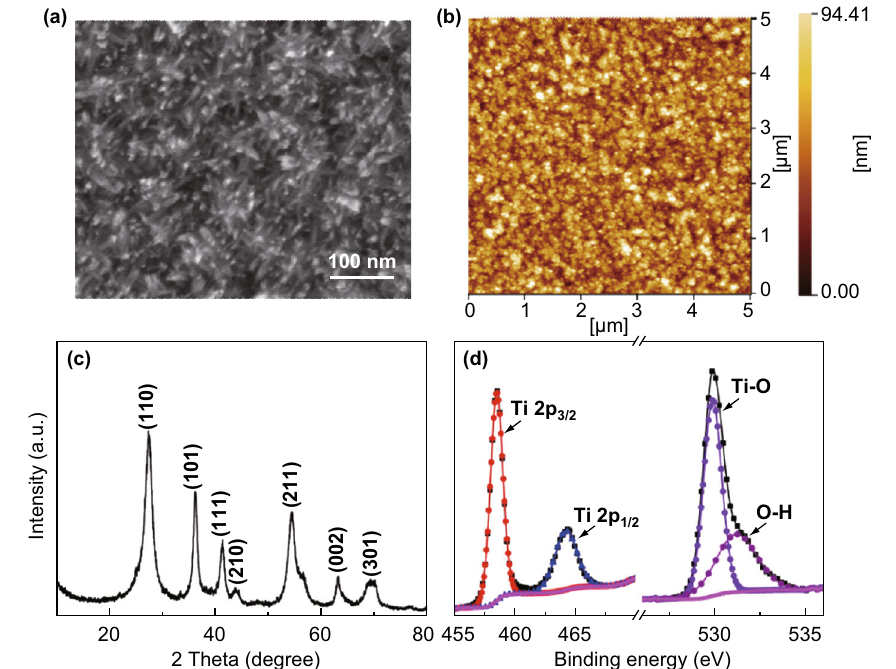
Fig. 2 a SEM, b AFM images of the TiO 2 films obtained by SAH with a 0.4-M TiCl 4 precursor solution. c XRD patterns, d XPS results of the TiO 2 material scratched from the TiO 2